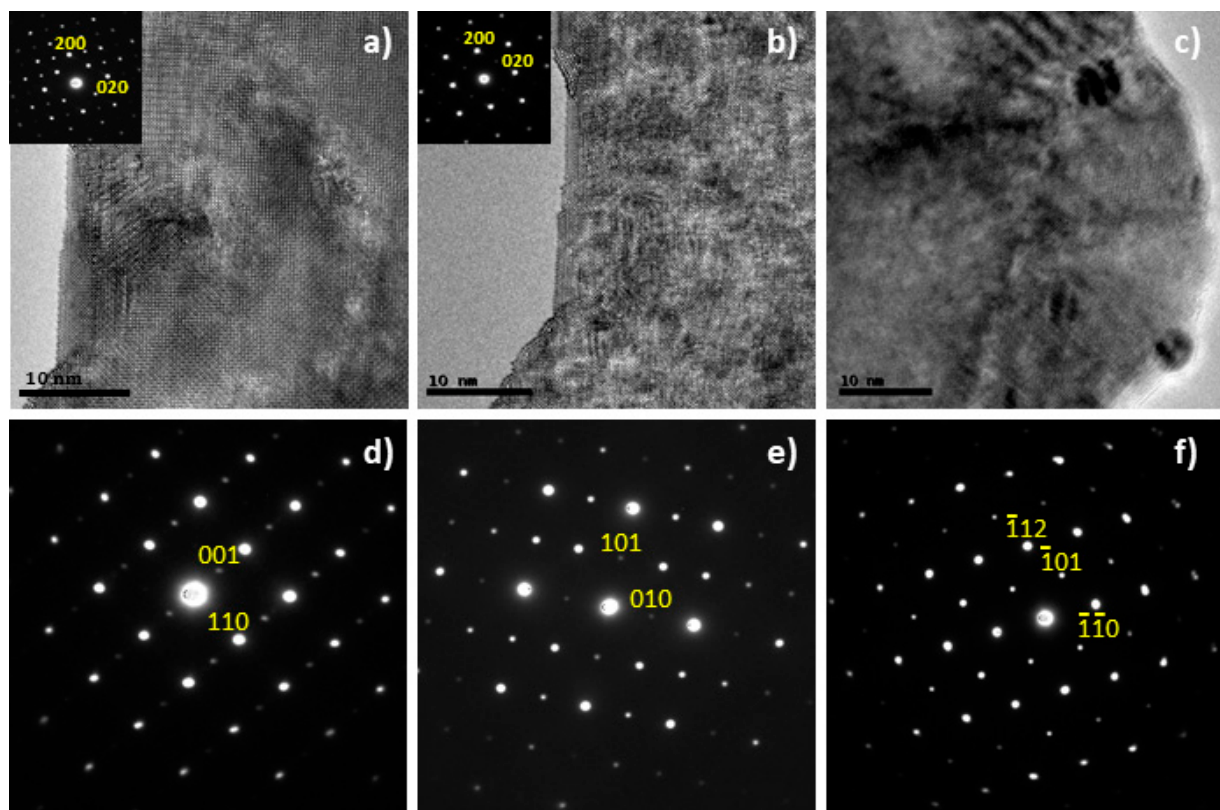
Figure 2. HRTEM images showing a view down the [001] in La 2 NiTiO 6 −δ , ( a ) time = 0 and ( b ) time = 60 s. Under beam irradiation, the perovskite undergoes ion rearrangement resulting in a more disordered matrix. The insets correspond to the SAED patterns that also highlight such change. ( c ) TEM image of as prepared La 1.8 NiTiO 6 −δ revealing the presence of ex-soluted NiO nanoparticles. SAED patterns showing views down the ( d ) (cid:4670)11(cid:3364)0(cid:4671) , ( e ) (cid:4670)101(cid:3364)(cid:4671) and ( f ) (cid:4670)1(cid:3364)11(cid:3364)(cid:4671) zone axes of La 2 − x NiTiO 6 −δ phases.